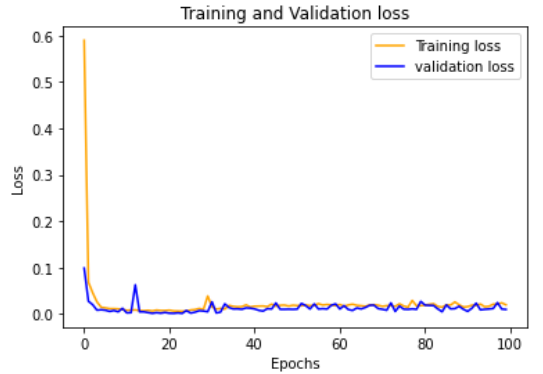
Figure 5. Training and validation loss with 100